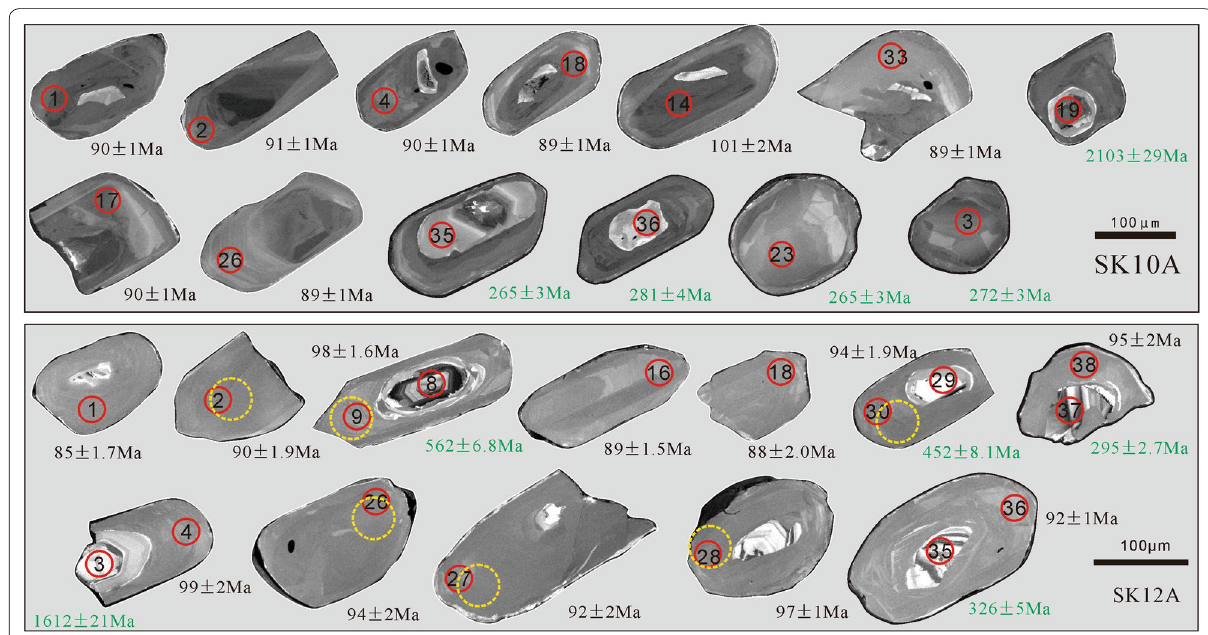
Fig. 6 CL images of the leucogneiss samples (SK10A, SK12A). Red circles are the locations of U/Pb dating spots, the yellow ones the locations of Hf isotopic measurements. Green numbers highlight ages of inherited